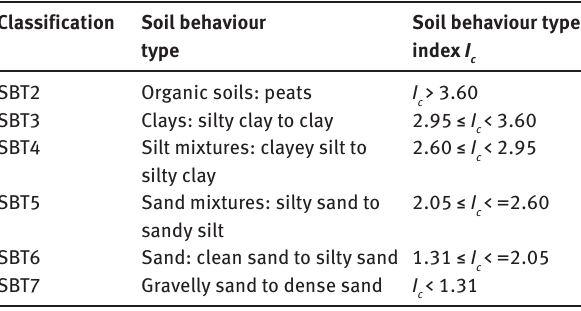
Table 3: SBT index classification proposed by Robertson and Wride [8]